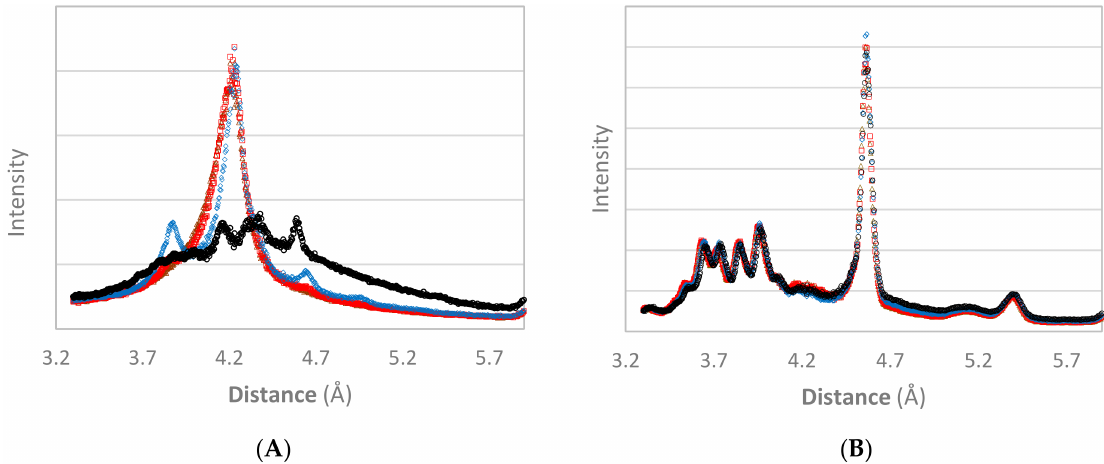
Figure 1. WAXD (wide angle X-ray diffraction) pattern of non-tempered ( A ) and tempered ( B ) cocoa butter obtained after 90 min at 0 ◦ C (brown triangles), 60 min at 5 ◦ C (red squares), 60 min at 15 ◦ C (blue diamonds) and 60 min at 25 ◦ C (black